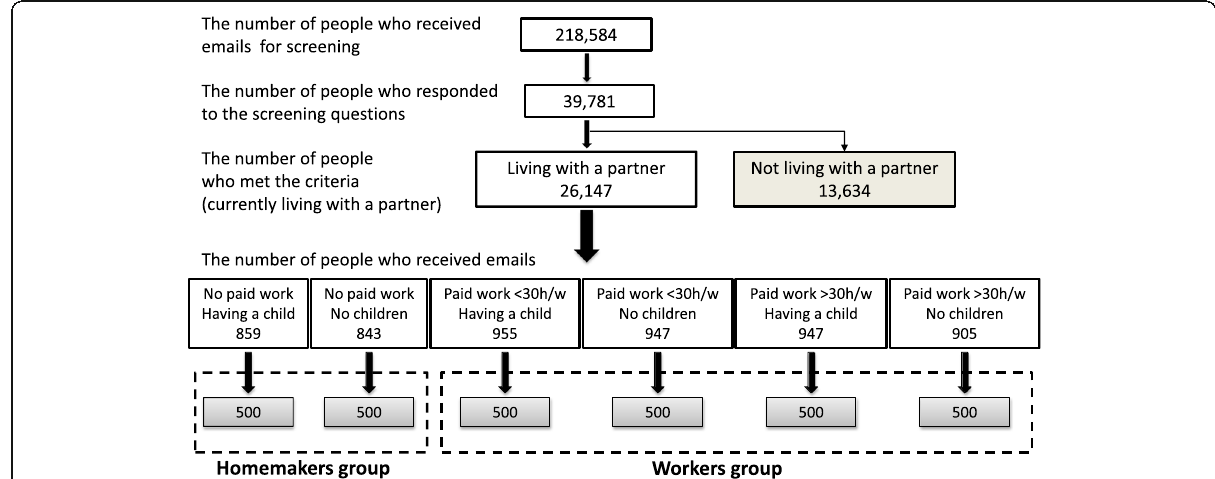
Fig. 1 Flowchart of the